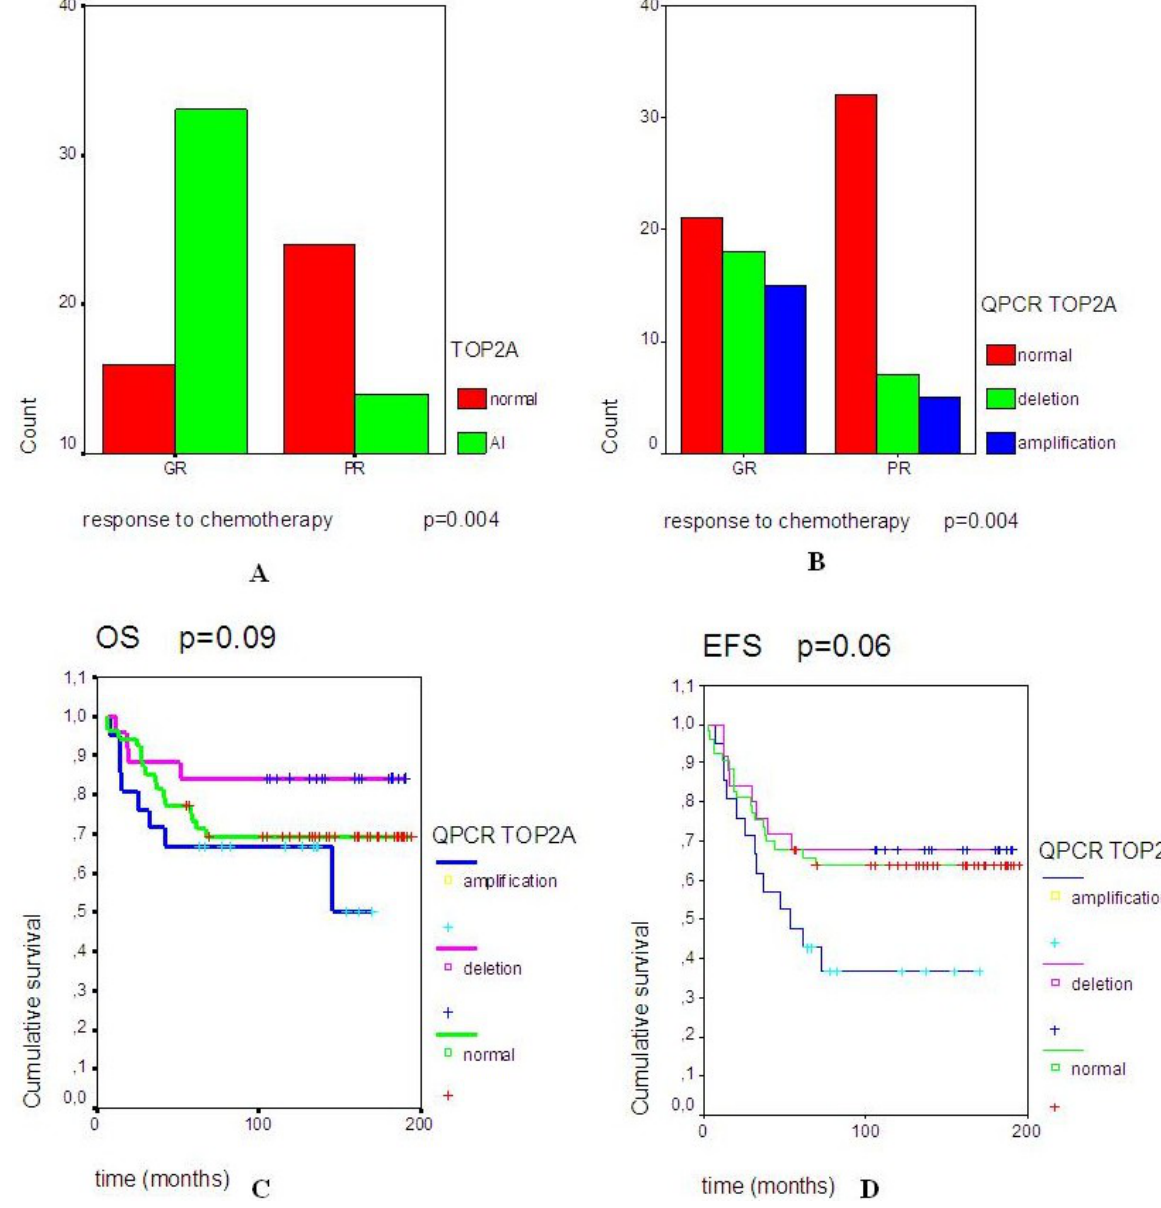
Figure 1. ( A ) shows the significant correlation ( p = 0.004) between the presence of an allelic imbalance (AI) and the good responders to neo-adjuvant chemotherapy (GR). ( B ) focuses on the significant correlation ( p = 0.004) between the chemoresponse [GR or poor response (PR)] and TOP2A gene status. ( C ) and ( D ) are representing the overall survival (OS) and event-free survival (EFS) curves in the 3 subgroups of patients,